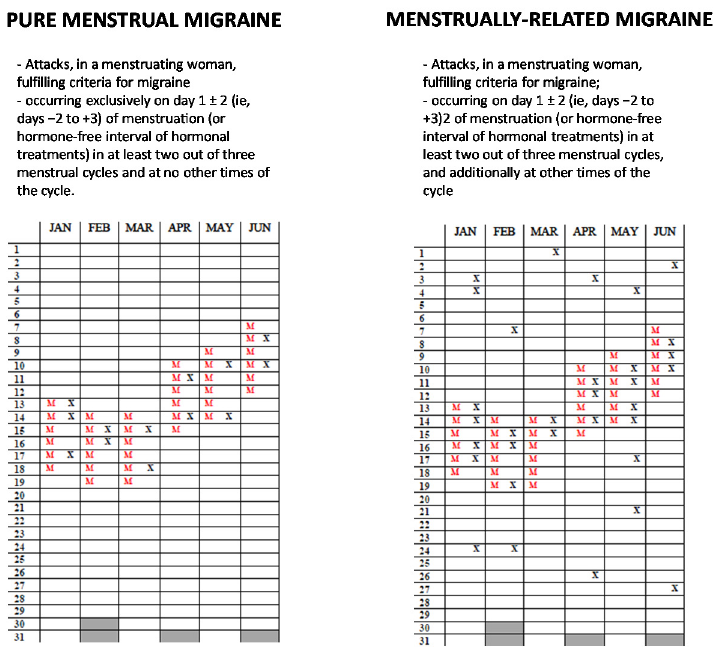
Figure 2. Example of headache diary of patient with pure menstrual and menstrual-related migraine. The Xs represent headache days; Ms represent reported menstruation days.